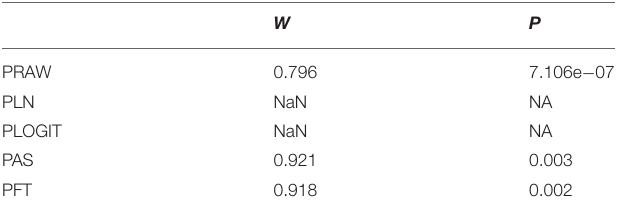
TABLE 1 | Normal distribution test for the normal rate and the different conversion of the normal rate.